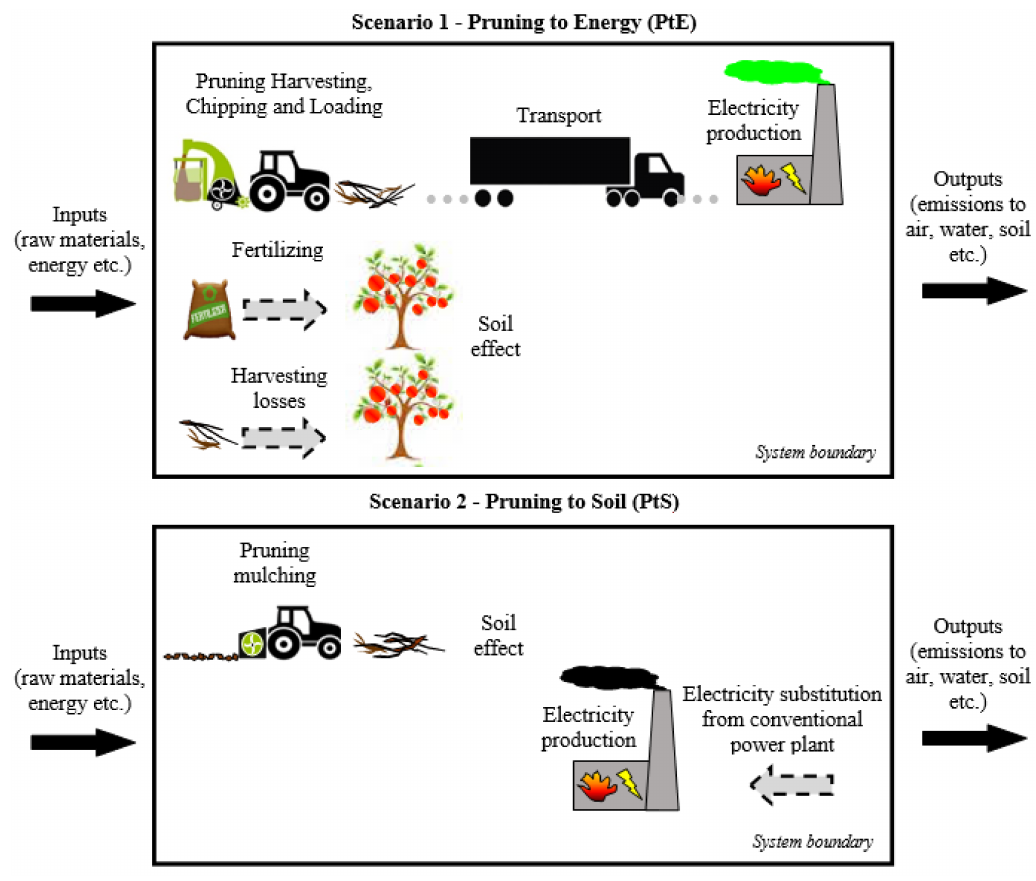
Figure 2. System boundaries both scenarios: pruning to energy (PtE, Scenario 1) and pruning to soil (PtS, Scenario